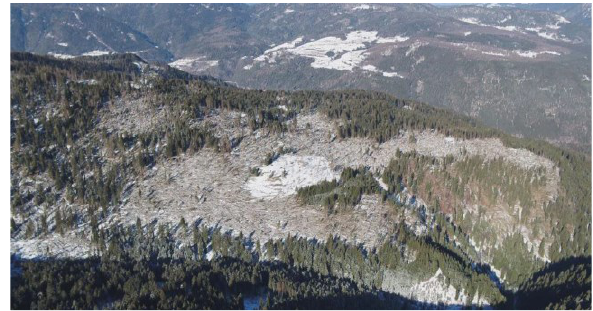
Figure 2. Damaged areas (courtesy of A.von Longo